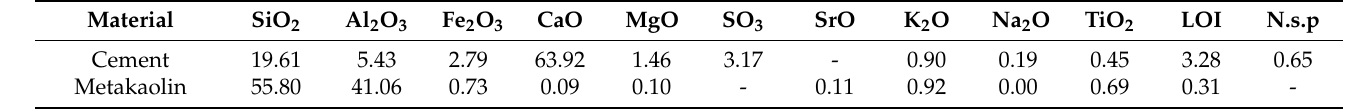
Table 1. Chemical composition of cement and